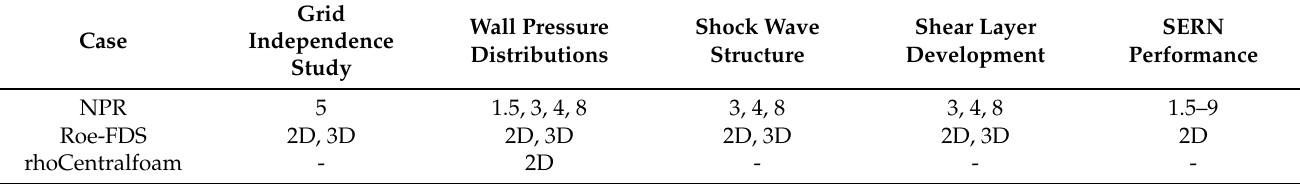
Table 3. A summary of the test